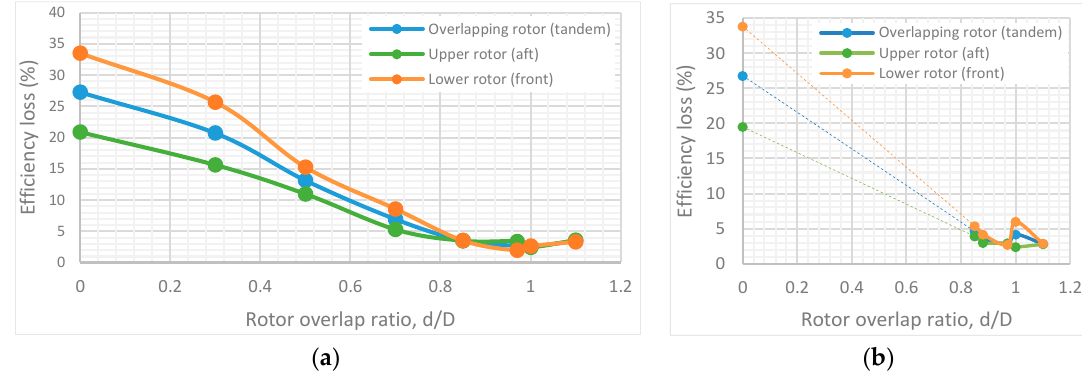
Figure 18. Overlapping rotor (tandem) performance in terms of percentage efficiency loss over two isolated rotors ( z / D = 0.05): ( a ) overall thrust = 8 N; and ( b ) overall thrust = 15 N.